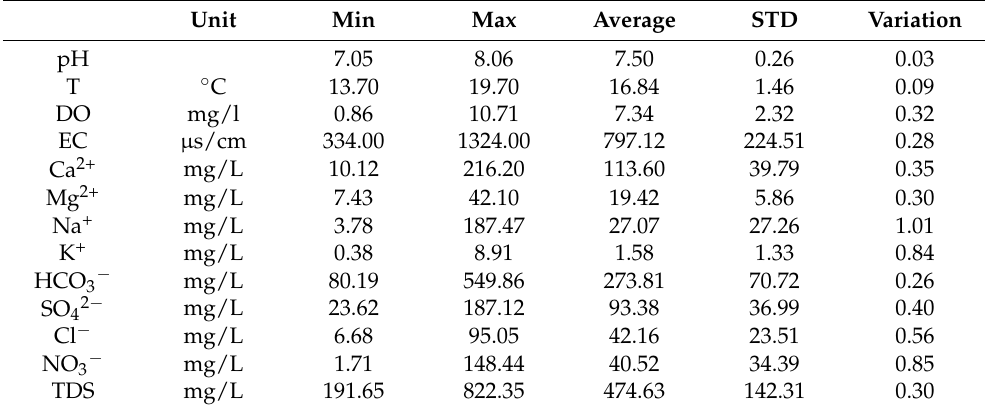
Table 2. Summary of chemical data and in situ physico-chemical parameters of the collected karst water samples. Concentration in mg/L, except pH and temperature (T).